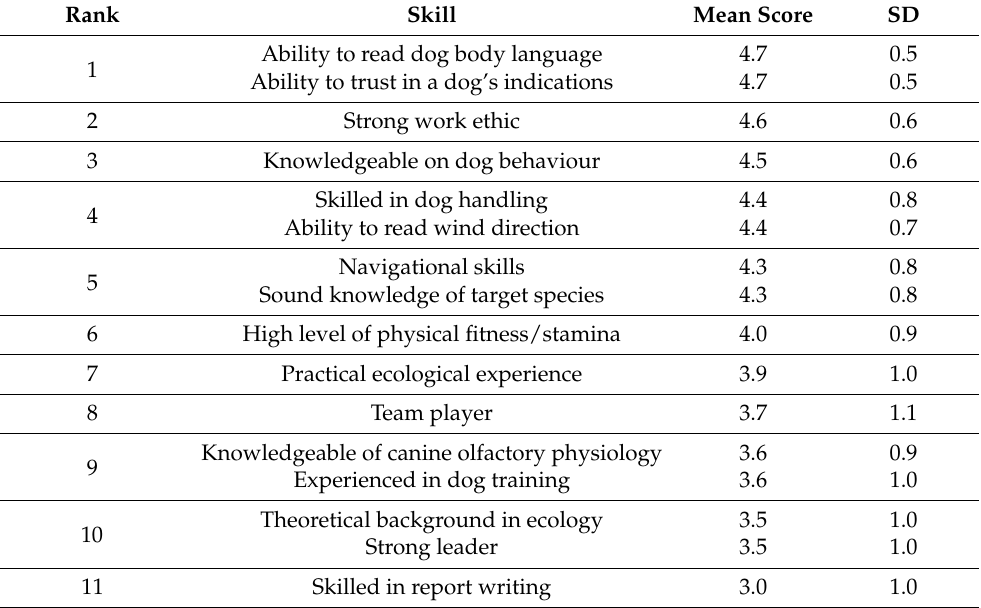
Table 2. Scoring of skills and knowledge based on their importance and relevance for wildlife detection dog handlers (1: strongly disagree it is important, 5: strongly agree it is important; SD: standard